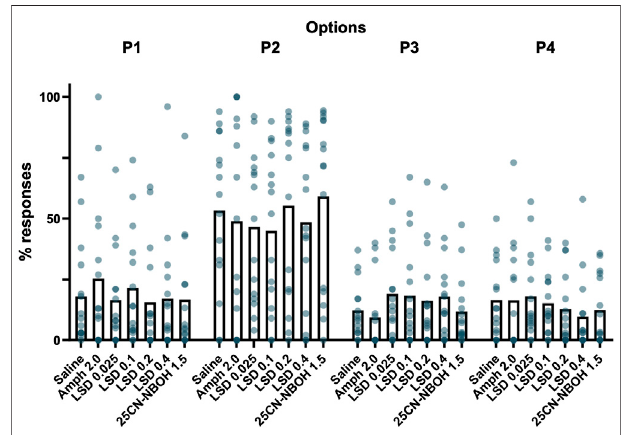
FIGURE 3 | Mean percentages of choices in each reinforcement option respectivelyduringthedifferentdrugtreatmentsessionsoftheIowaGambling Taskphase.Noneoftheacutedrugtreatmentsshowedstatisticallysigni fi cant effects on the reward-driven option selection. The dots depict values of individual